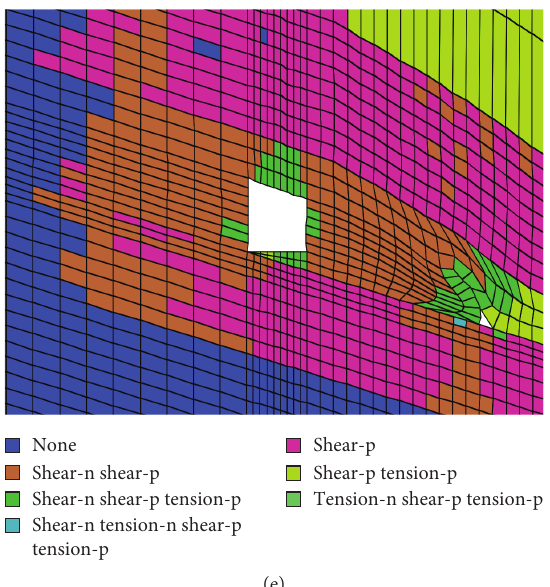
Figure 11: Distribution of the plastic zone in the mining gateway with different coal pillar widths: (a) 3m, (b) 5m, (c) 7m, (d) 8m, and (e)